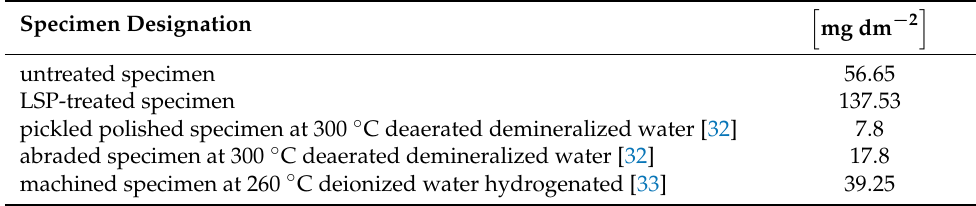
Table 4. Corrosion rate of AISI 304L in high-temperature aqueous